Question: Summarize what this figure shows in one sentence.
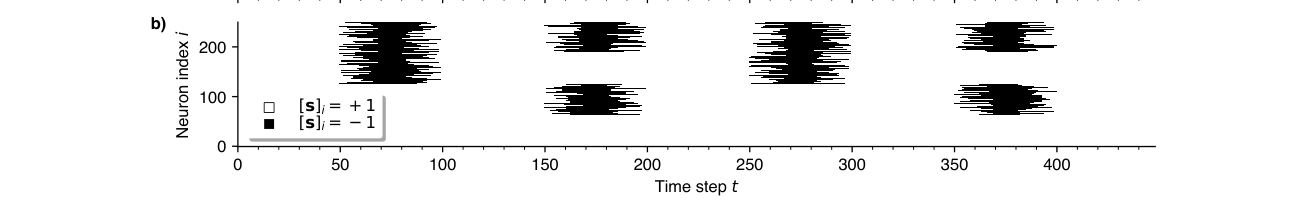
Answer: The attractor network performing a walk as masking input is applied asynchronously over multiple time steps with random delays. a) The similarities between the network state zt and stored node hypervectors x ∈XAN. b) A subset of the stimulus hypervector s being applied to the network as a mask at each time step. Indices which are black on any time step have [s]i = −1 and so are being masked by the stimulus. For visual clarity, the two stimulus hypervectors shown were manually chosen, rather than randomly generated. The attractor transition dynamics are thus robust to input asynchrony when the input is modelled as a component-wise masking of the network state.